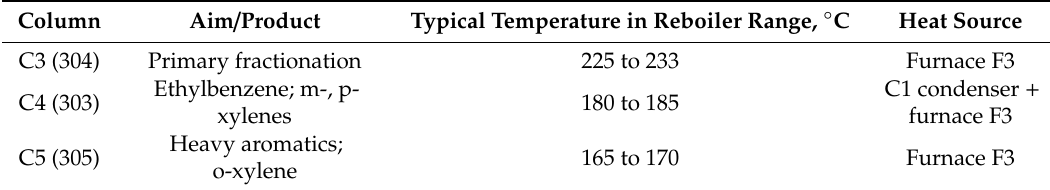
Figure 4. Part of the C8+ aromatics splitting process. Table 2. Basic parameters of C8 + aromatics splitting